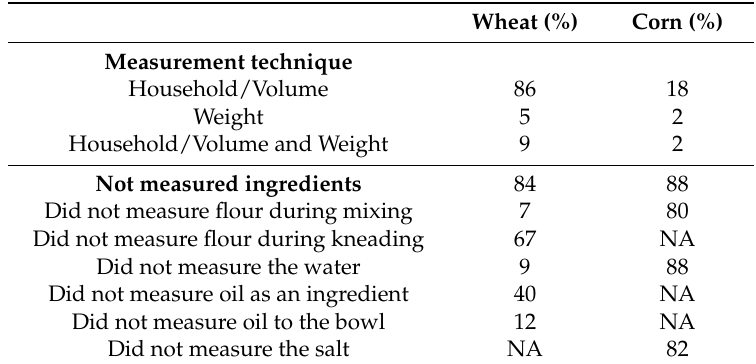
Table 4. Measurement techniques mostly used by 43 wheat dough preparers and 50 corn dough preparers during the dough preparation sessions.